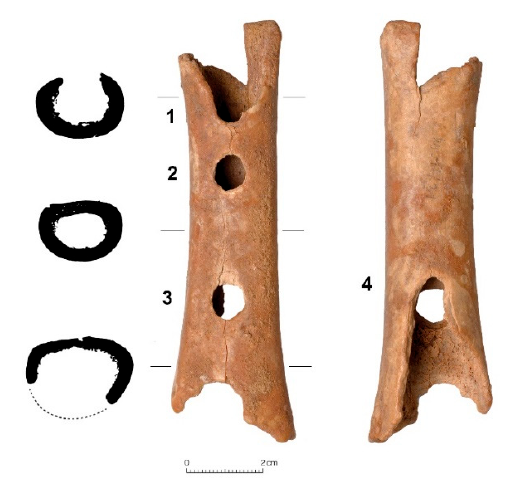
Figure 1. The perforated femur diaphysis no. 652 from Divje babe I with two complete (nos. 2 and 3) and two partially preserved holes (nos. 1 and 4). Soon after discovery, the question arose whether it was a Neanderthal musical instrument or simply a bone pierced and gnawed by a carnivore (photo Tomaž Lauko, NMS).